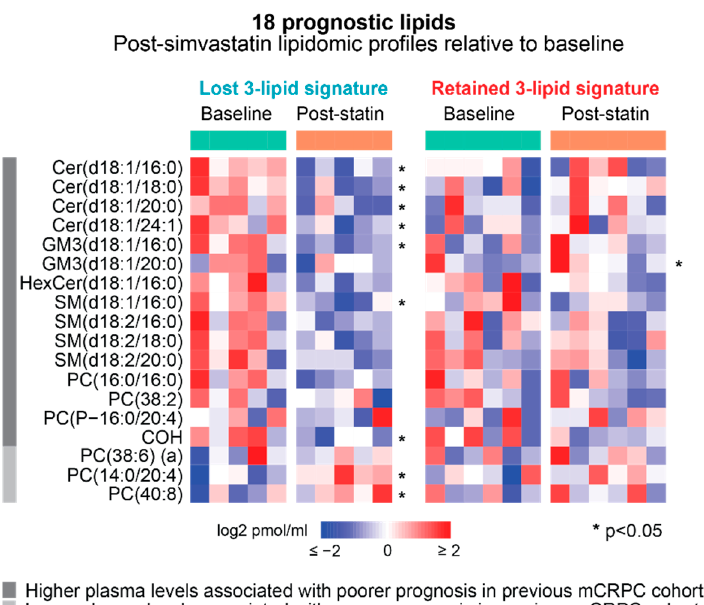
Figure 5. Heatmaps of change in the levels of 18 prognostic lipids in post-simvastatin lipidomic profiles relative to baseline, in men who lose the 3-lipid signature and those who keep the 3-lipid signature. * Significant differences, p -value < 0.05 by paired t-test. Prognostic association in previous mCRPC cohort refers to Lin et al. (2017) [4].